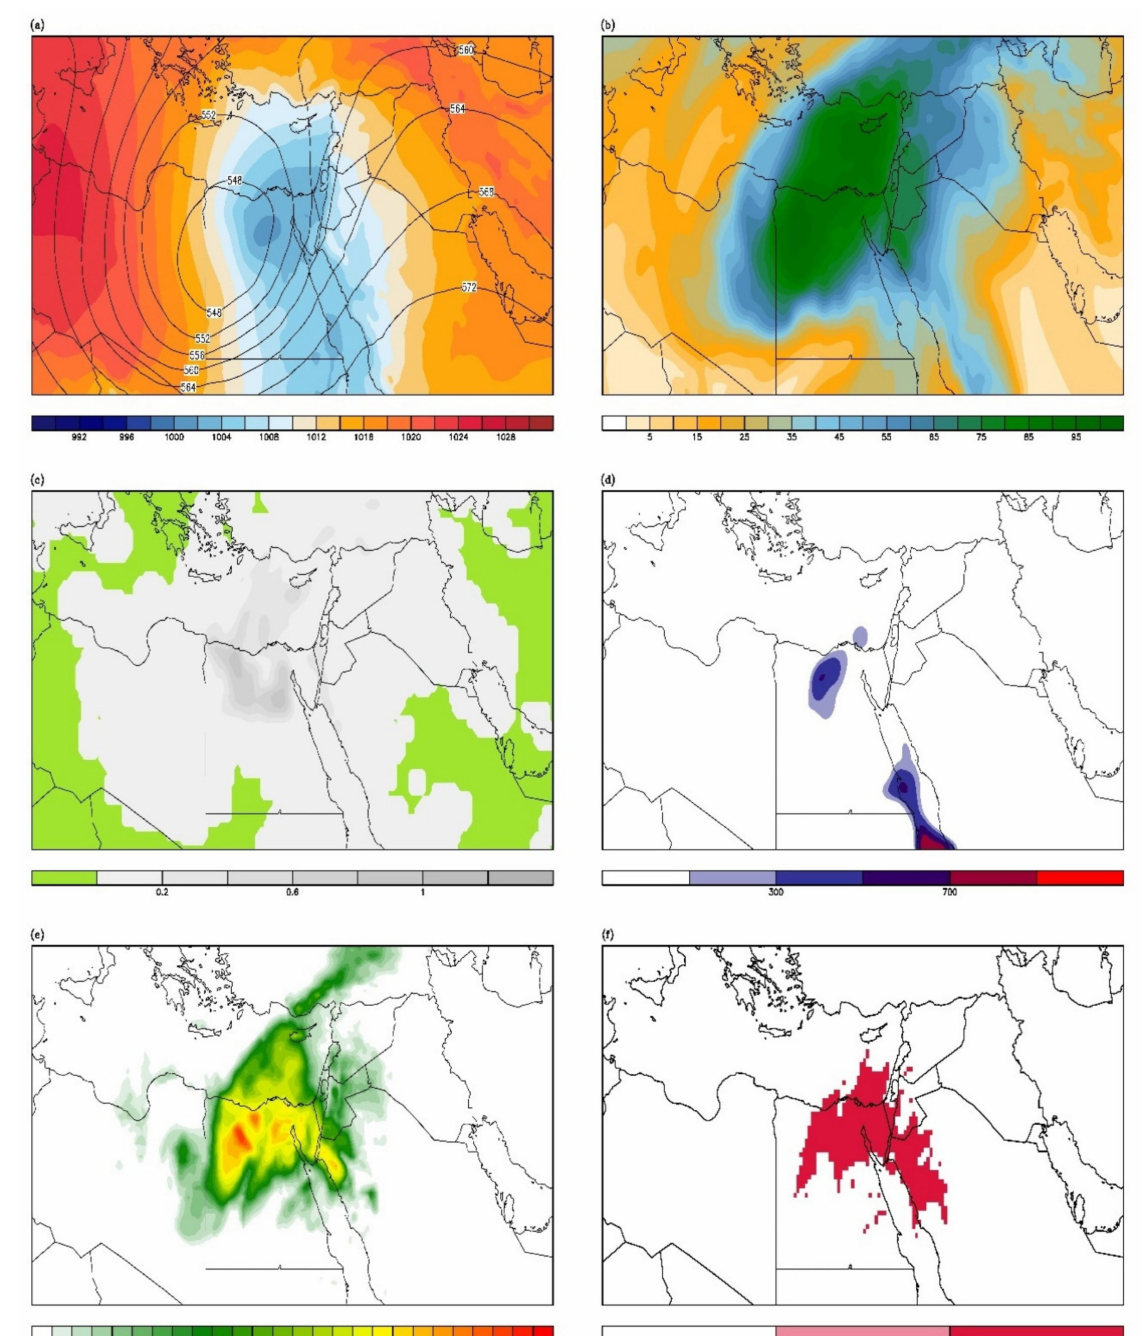
Figure 1. ( a ) Daily average pressure mean sea level (shaded) [hpa] with a geopotential height at 500 hpa (contour) [gpm], ( b ) daily average relative humidity at 700 hpa [%], ( c ) highest total air column water content (kg m − 2 ), ( d ) highest CAPE(J/kg), ( e ) daily accumulated rainfall [mm], ( f ) daily total lightning locations from the World Wide Lightning Location Network (WWLLN) data on 12 March 2020 from the ERA5